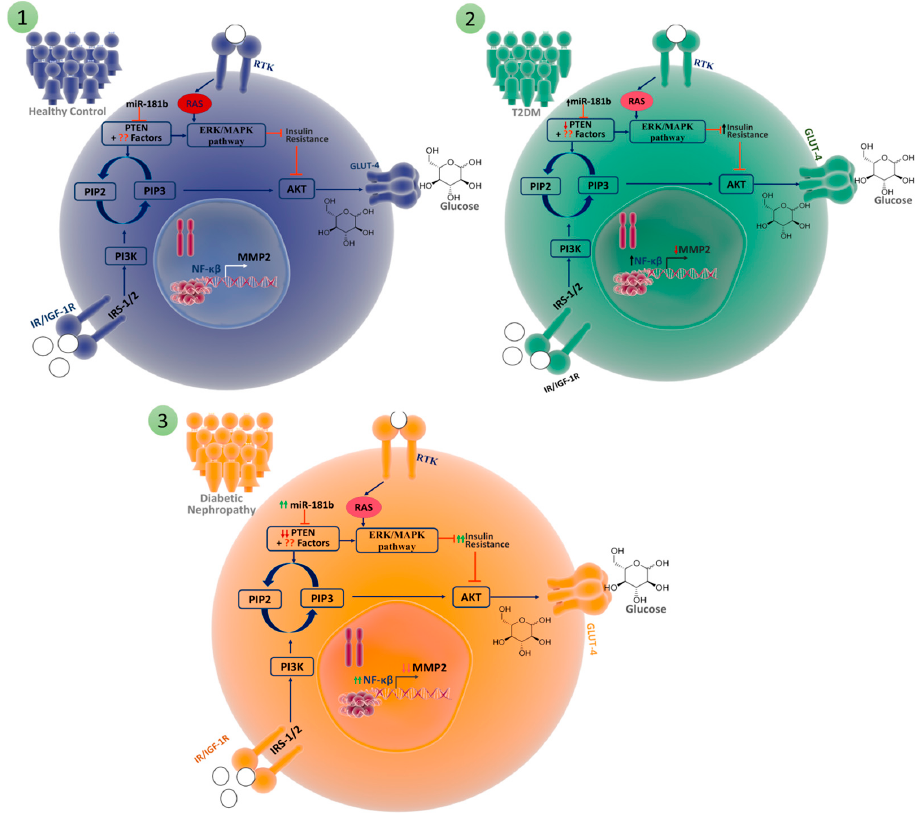
Figure 8. We have illustrated the pathway in three distinct conditions: ( 1 ) healthy controls, ( 2 ) individuals with type 2 diabetes, and ( 3 ) individuals with diabetic nephropathy. These conditions were compared to analyze insulin resistance and its impact on the pathway with diabetic nephropathy for comparative analysis via the collective effect of the balance between the ERK/MAPK pathway and the PTEN-Akt-m-TOR pathway. PI3K plays a crucial role in the insulin signalling pathway and on GLUT4 translocation, affecting the response of the cell to hyperglycaemia. PTEN antagonizes the PI3-kinase/AKT pathway by reconverting phosphatidylinositol 3,4,5-triphosphate (PIP3) back to phosphatidylinositol 3,4-bisphosphate (PIP2). PTEN acts as a negative regulator of the PI3K/Akt pathway and as a positive regulator of the ERK/MAPK pathway. Hence, the phenotype of IR is a collective effect of the balance between the two pathways (PI3K/Akt and ERK/MAPK) and is regulated by multiple factors, including PTEN [6,7]. Therefore, the altered PTEN expression observed in our study in patients with DN, in conjunction with other key regulators, may have tilted the balance towards IR, facilitating the progression of T2DM to DN.